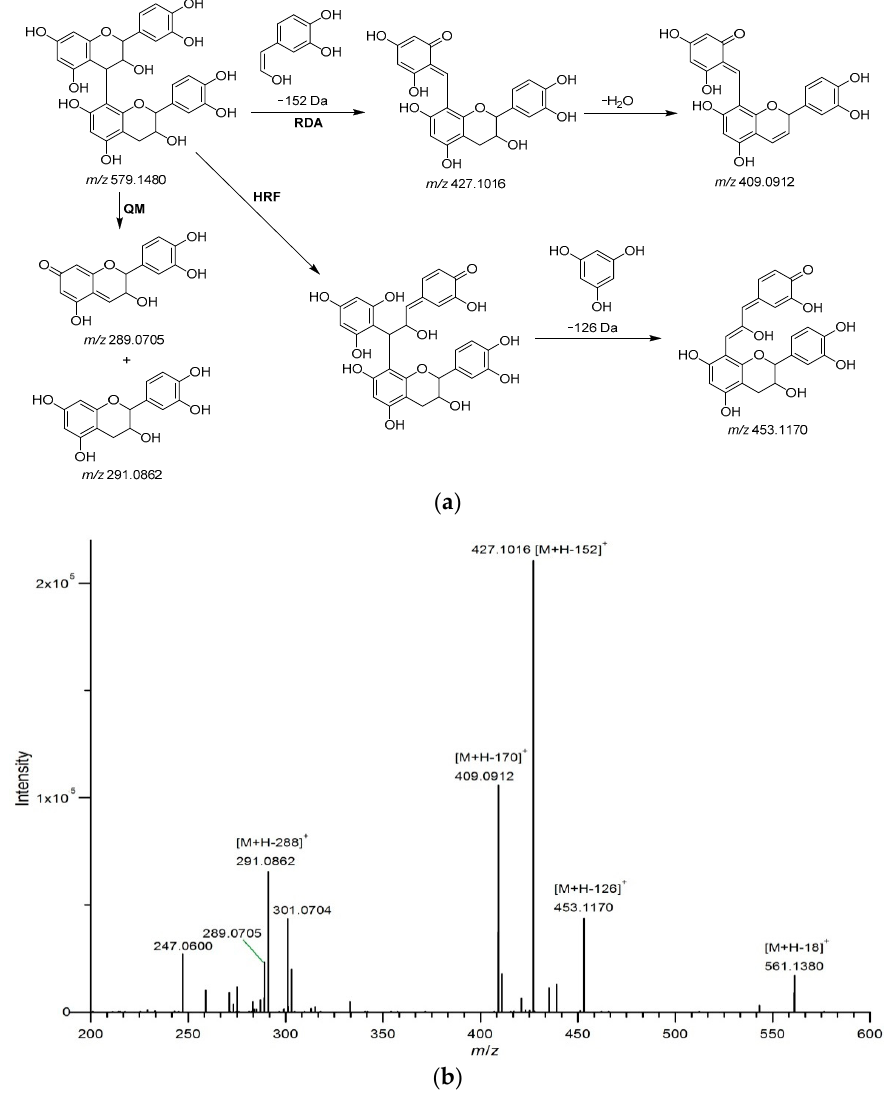
Figure 3. Fragmentation pathway ( a ) and MS 2 spectrum ( b ) of B-type procyanidin dimers. The fragment mechanisms are RDA (retro-Diels-Alder), HRF (heterocyclic ring fission), and QM (quinone methide) cleavage.